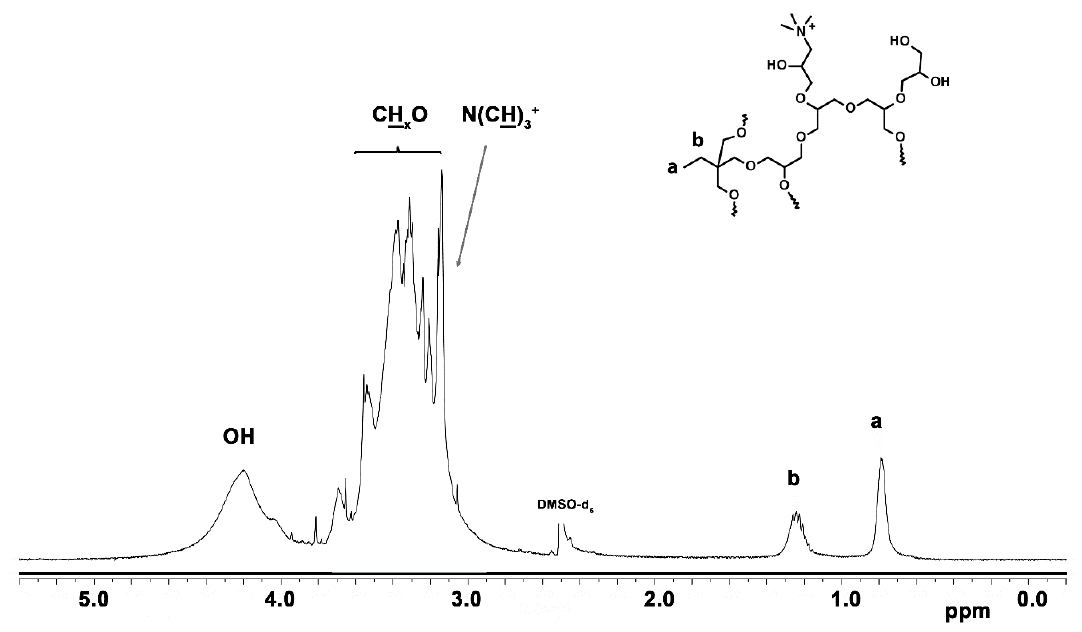
Figure 7. 1 H NMR (DMSO–d 6 , 400 MHz) spectrum of 6 copolymer.